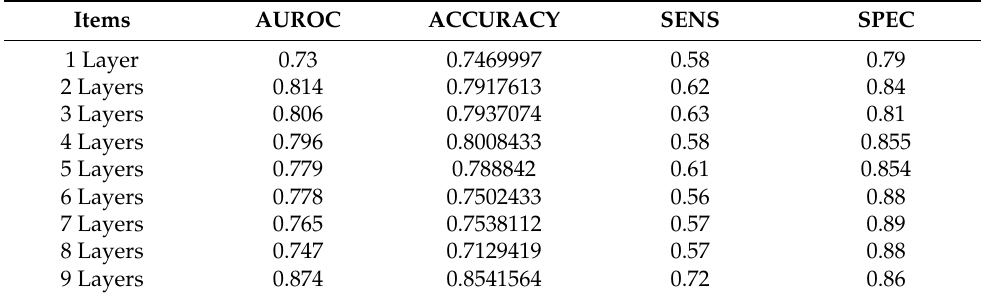
Table 4. Performance of Different DNN Structures.